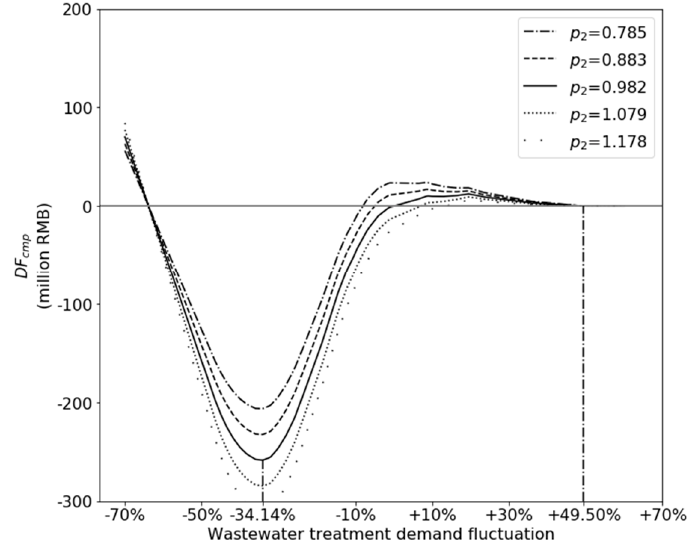
Figure 7. Change in decision factor based on the wastewater treatment demand fluctuation.